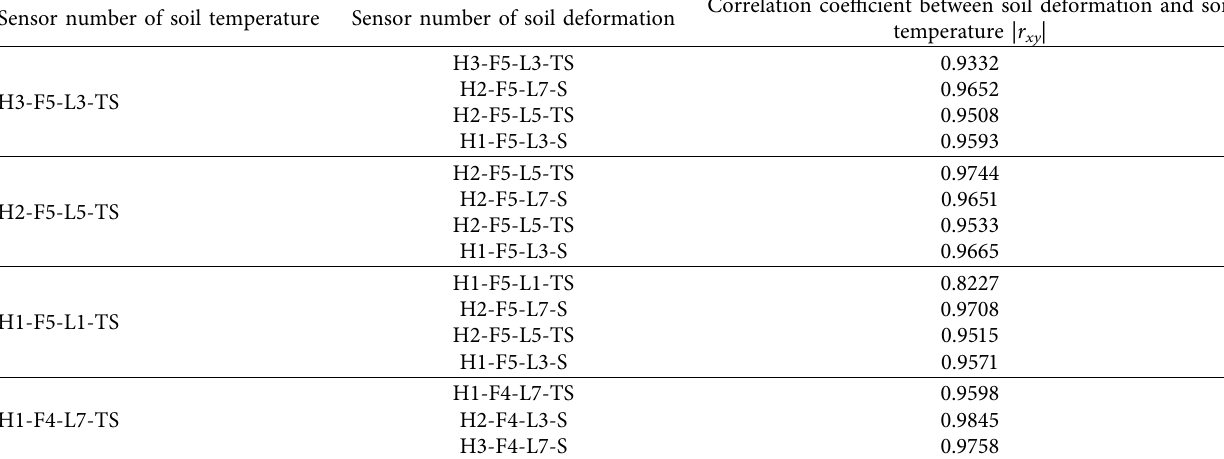
Table 7: Correlation coefficient of roadbed soil deformation and soil